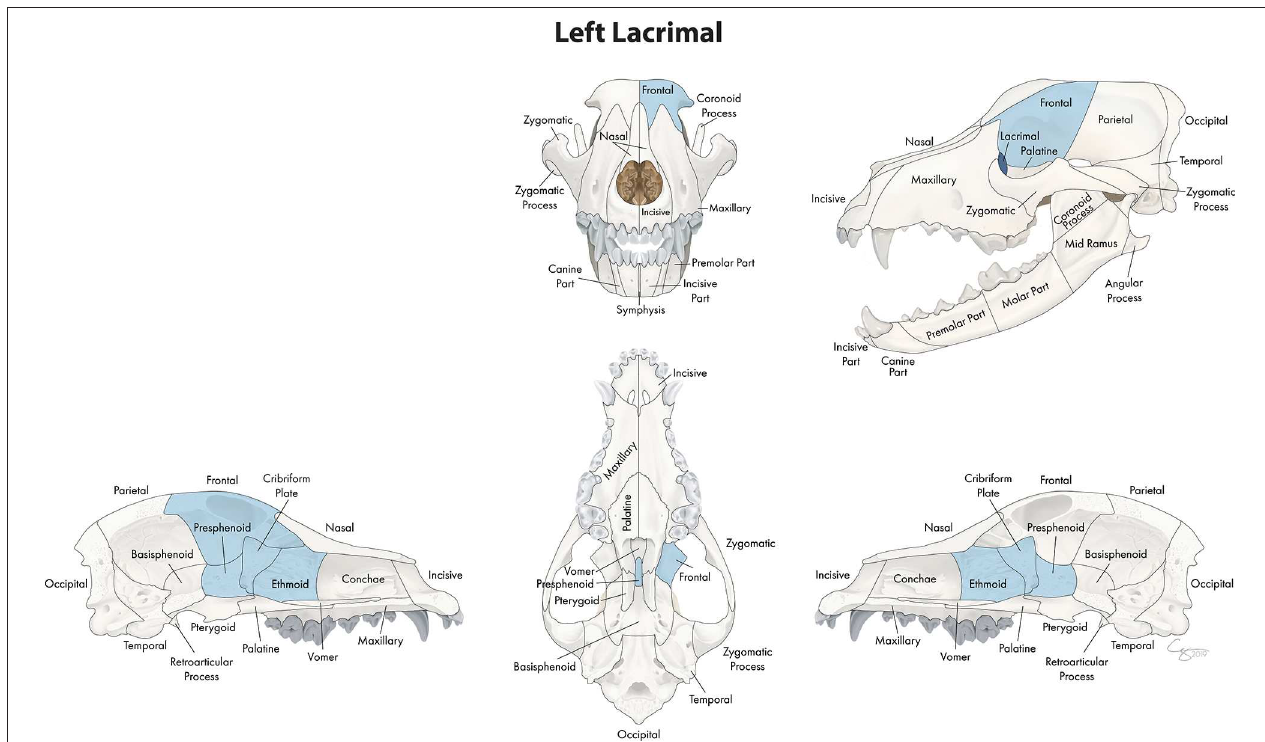
FIGURE 2 | Significant bones or regions fractured concurrently with the lacrimal bone. When the lacrimal bone was the region of interest, the cribriform plate, ethmoid, presphenoid, and ipsilateral frontal bones fractured concurrently. Although the left lacrimal bone is shown, when the right lacrimal bone was the region of interest, a mirror image of concurrently fractured locations applied. Only views of the skull that demonstrate a fractured region are